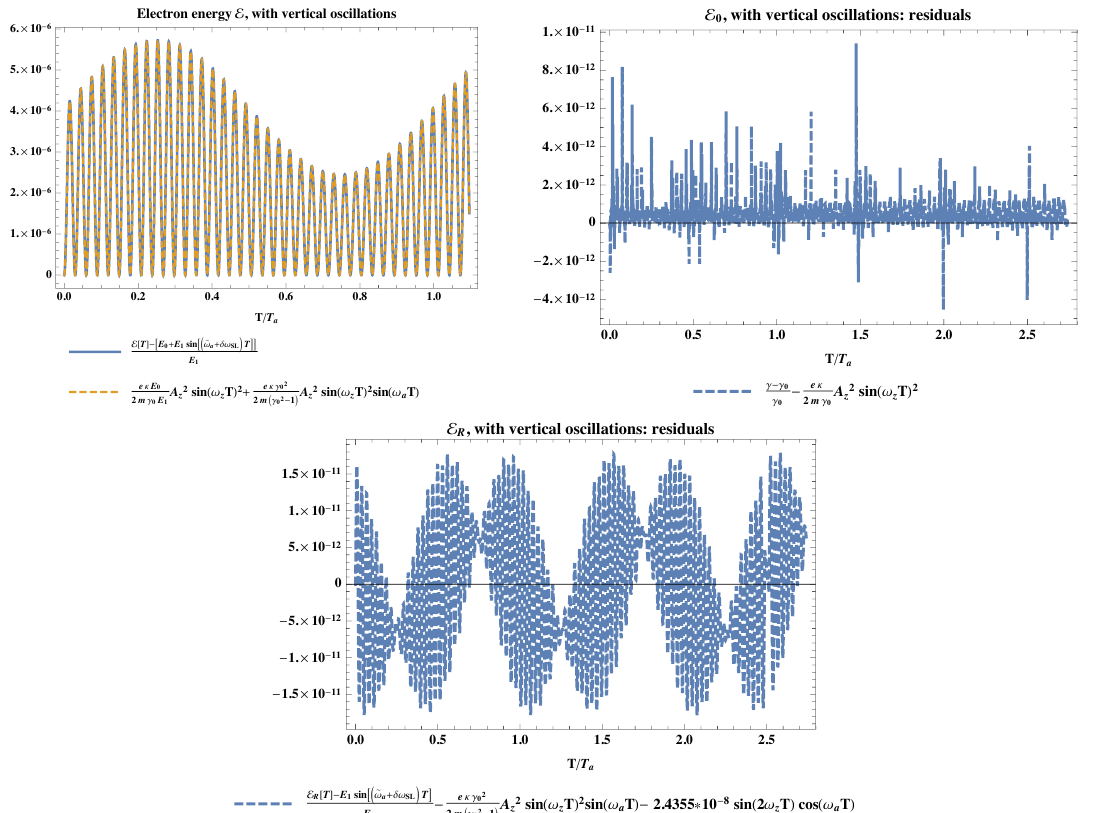
Figure 4 . We have solved numerically the equations of motion, with a vertical displacement, and then evaluated the energy E on the solution and compared to a simple sinusoidal behavior E 0 + E 1 sin((~ ! a + (cid:14)! SL ) T ), where E 0 and E 1 are constants. The upper left plot shows the deviation form such a simple behavior and the analytical form of the residual of eqs. (6.21), (6.22). The upper right plot shows the residual for E 0 , eq. (6.28). The bottom plot shows an analytical (cid:12)t of the residual, for E R , given by eq. (6.29), plus higher order corrections that we have found numerically. Here T a (cid:17) 2 (cid:25)=! a